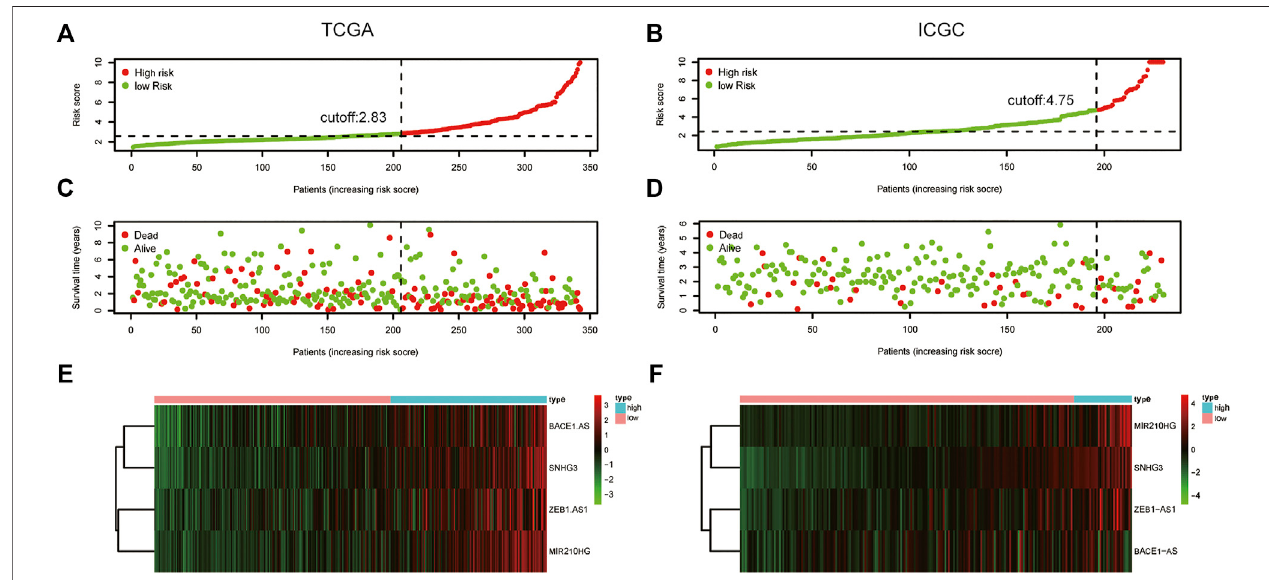
FIGURE6| Thedistributionofriskscore,survivalstatus, andfour lncRNAs expression. (A) The distribution ofm6A-related lncRNA riskscorein theTCGAdataset; (B) The distribution of m6A-related lncRNA risk score in the ICGC dataset; (C) The distribution of the survival status of HCC patients in the TCGA dataset; (D) The distributionofthesurvivalstatusofHCCpatientsintheICGCdataset; (E) Theexpressionmatrixheatmapoftheselectedfourm6A-relatedlncRNAsintheTCGAdataset; (F) The expression matrix heatmap of the selected four m6A-related lncRNAs in the ICGC dataset. HCC, Hepatocellular carcinoma; TCGA, The Cancer Genome Atlas; ICGC, International Cancer Genome Consortium.